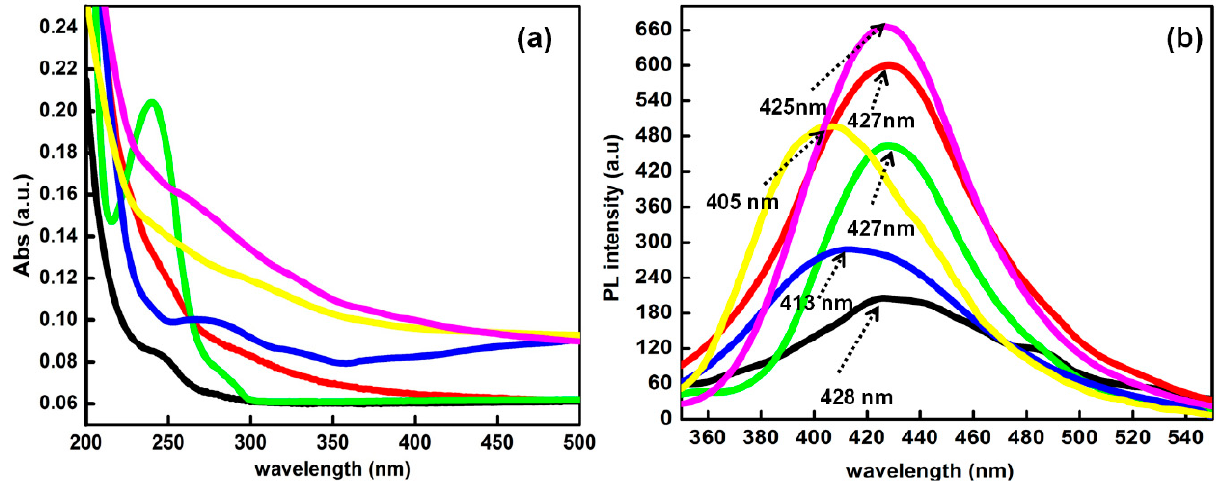
Figure 3. ( a ) UV-visible and ( b ) fluorescence emission profile of C-dots and their counterpart ACs at an excitation wavelength of 310 nm.